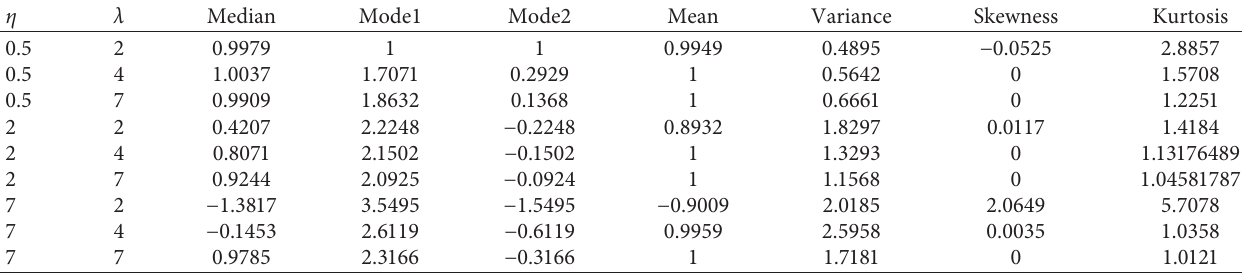
Table 2: Median, Mode, Mean, Variance, Skewness, and Kurtosis of BG Γ M.